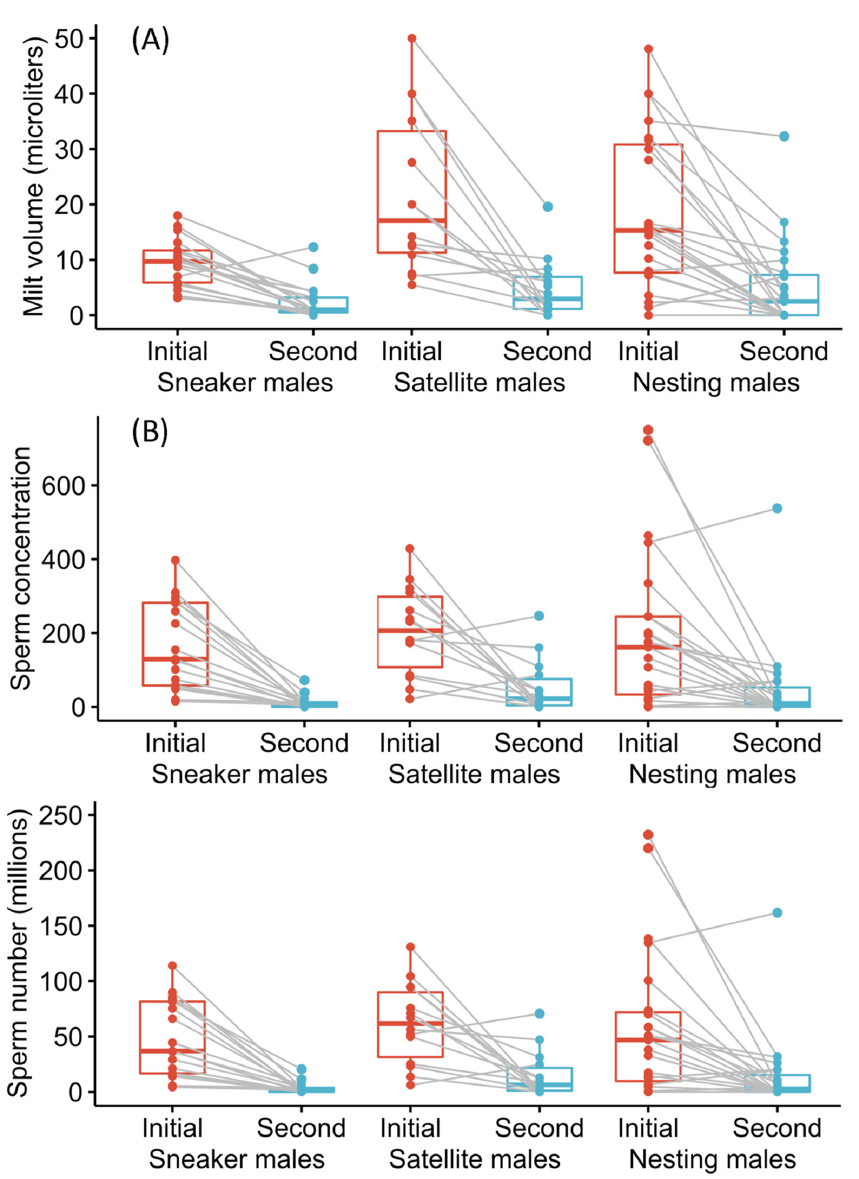
Figure 3. Ejaculate (sperm and seminal fluid) production differs among male types. Initial ejaculate volume (in μ L) differed among alternative male types ( A ), while sperm concentration (mean number of sperm cells per microscope image) ( B ) and the total number of sperm cells estimated to be in the entire sample (in millions) ( C ) did not differ among alternative male types. Ejaculate volume, sperm concentration, and sperm number was greater in the initial samples than the second (5 h later) ejaculate samples for all male types. Male types did not, however, differ in sperm or seminal fluid regeneration (i.e., the difference between first and second milt samples). Sneaker male initial ejaculate samples were significantly smaller than satellite or nesting male samples (based on ANOVA followed by Tukey post hoc comparisons). For all three variables and male types, the change between first and second samples was significantly greater than zero (i.e., first sample − second sample). See text for full statistical